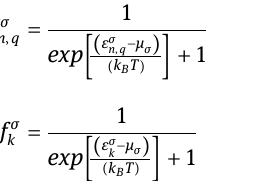
Figure 4: (a) Gain and (b) linewidth enhancement factor ( α H -factor) spectra for InAs QD structure at carrier densities 0.6 × , 2 × , 6 × 10 11 cm − 2 (black, red, and blue curves, respectively). For the calculations,